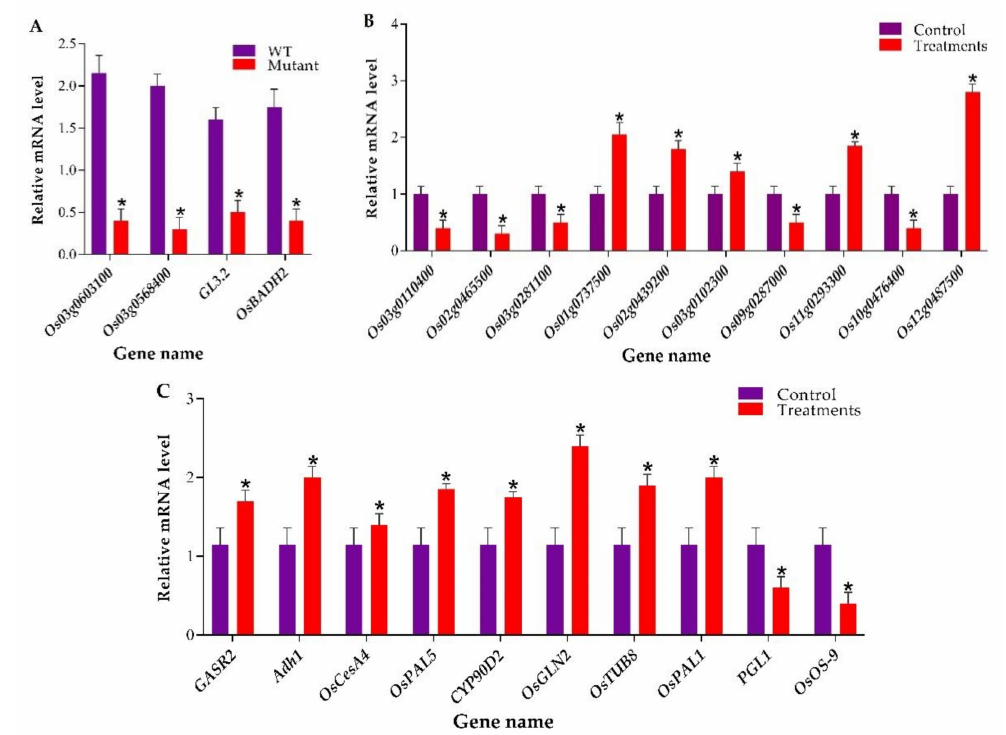
Figure 5. RT-qPCR-based assessment of target genes expression analysis and validation of transcriptome and proteomic experiments. ( A ) Expression level of Os03g0603100 , Os03g0568400 , GL3.2 , and OsBADH2 in wild-type (WT) and mutant plants ( B ) Expression analysis of ten selected DEGs and ( C ) genes associated with DEPs. * Denotes a significant di ff erence, student’s t -test, p ≤ 0.01, n =